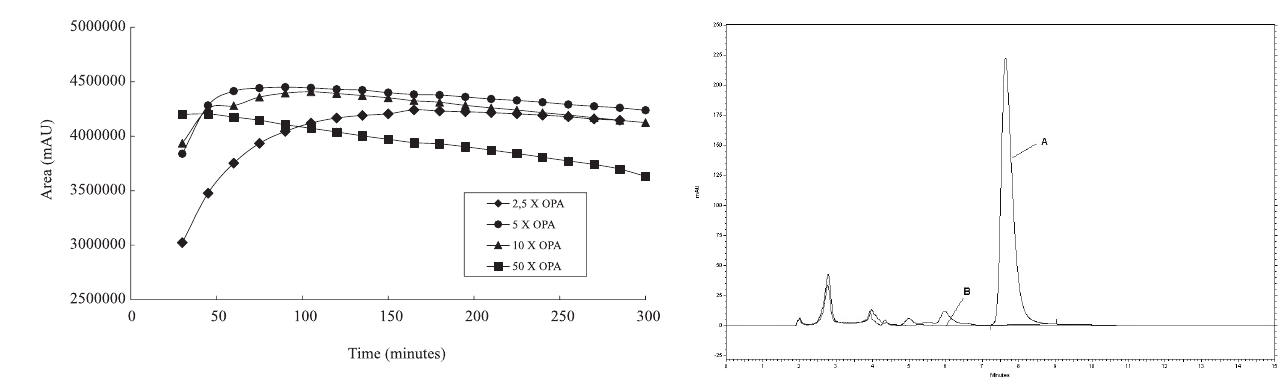
FIGURE 4 - Chromatographic profile of apramycin test solution (A) and blank solution (B) obtained with nominal method conditions after